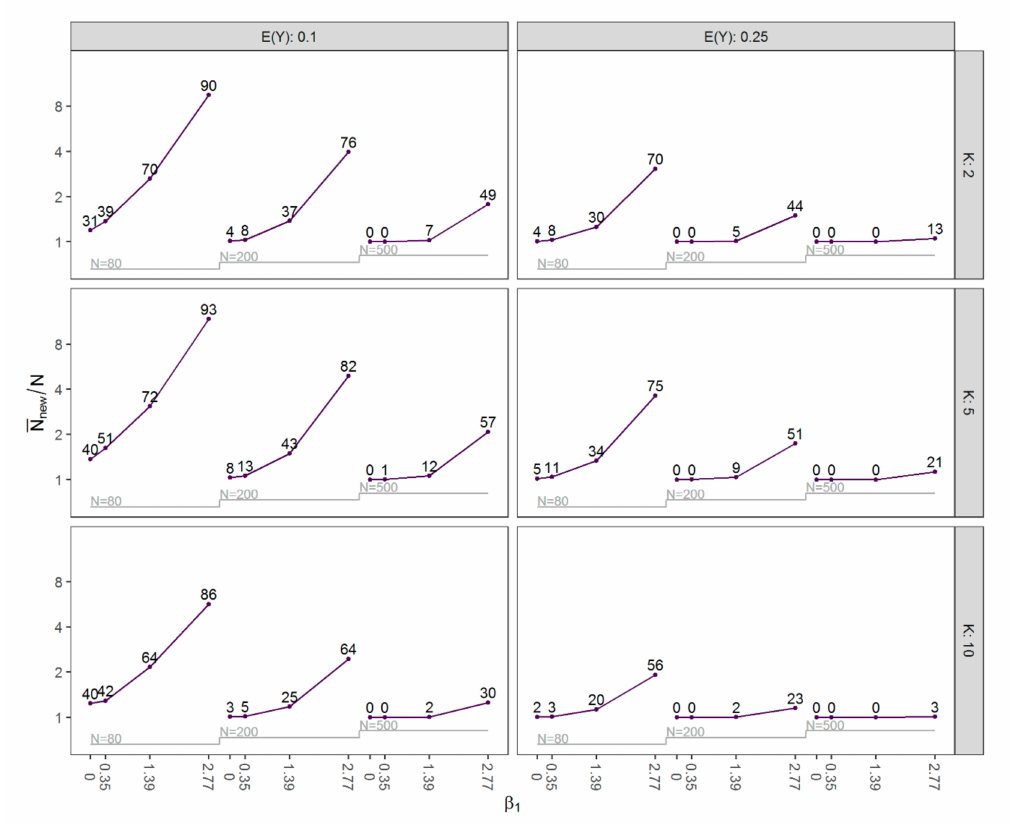
Figure 1. Nested loop plot of N new / N by the expected value of Y , E ( Y ) ∈ { 0.1, 0.25 } , the number of covariates K ∈ { 2, 5, 10 } , the value of β 1 ∈ { 0, 0.35, 1.39, 2.77 } , and the sample size N ∈ { 80, 200, 500 } for all simulated scenarios. The numbers indicate the prevalence of separation (%) with sample size N